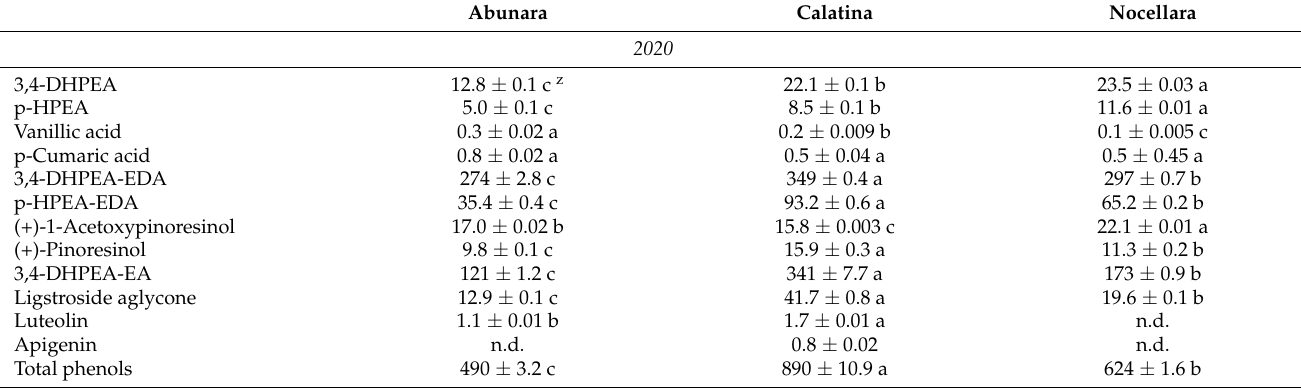
Table 4. Phenolic composition (mg kg − 1 ) of virgin olive oils from ‘Abunara’, ‘Calatina’, and ‘Nocellara del Belice’ olive trees grown as central leaders at 2 × 5 m (CLx2), free palmette at 3 × 5 m (FPx3), globe vase at 4 × 5 m (GVx4), and polyconic vase at 5 × 5 m (PVx5) in the last two years of trials. Data are expressed as means ± standard deviation (n = 12). For each cultivar, data from different planting systems were pooled